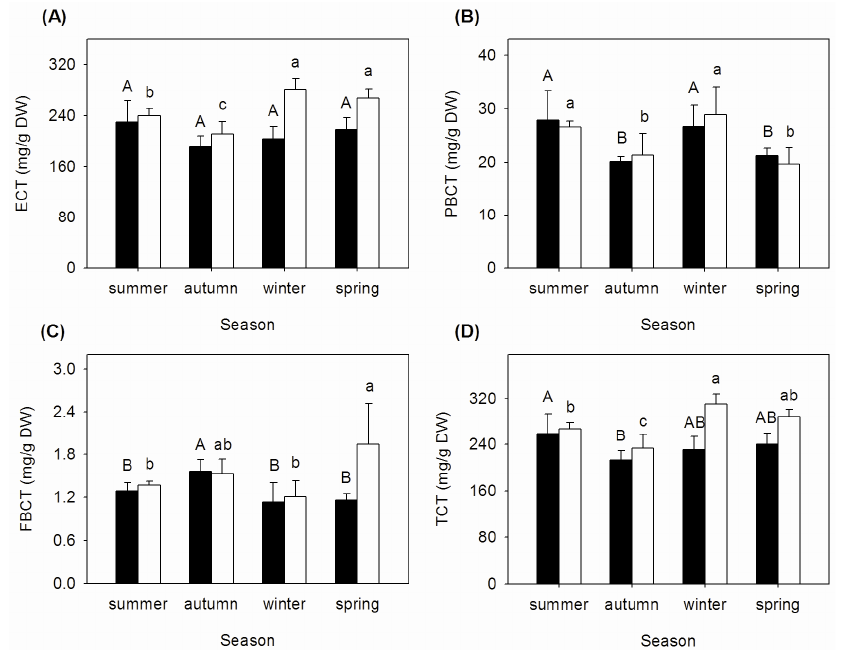
Figure 3. Seasonal changes in the concentrations of (A) extractable condensed tannins (ECT), (B) protein ‐ bound condensed tannins (PBCT), (C) fiber ‐ bound condensed tannins (FBCT), and (D) total condensed tannins (TCT) in leaves of A. corniculatum . Symbols are black bars for mature leaves and white bars for senescent leaves. Different capital letters indicate significant differences among seasons for ECT, PBCT, FBCT, and TCT concentrations in mature leaves at p < 0.05. Different lowercase letters indicate significant differences among seasons for ECT, PBCT, FBCT and TCT concentrations in senescent leaves at p < 0.05.